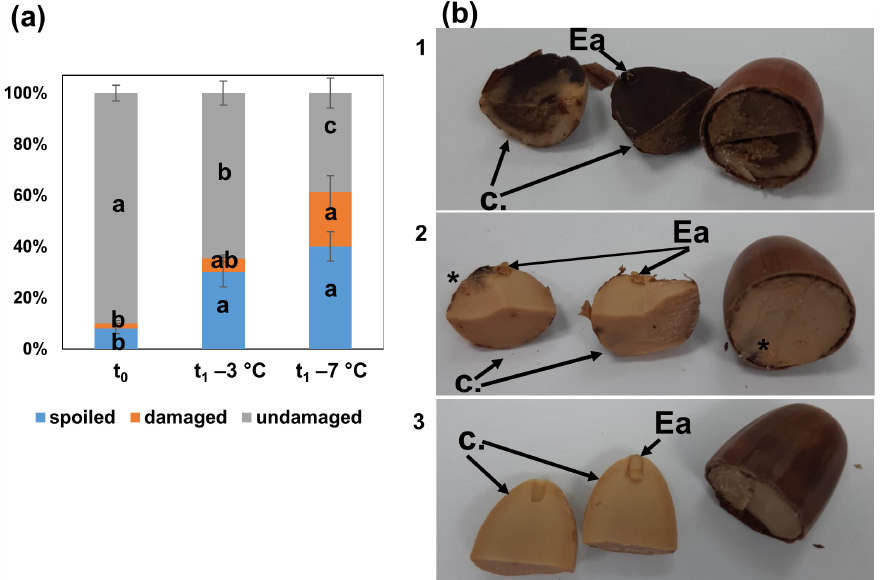
Figure 2. The percentage distribution ( a ) and visualization ( b ) of seed classes utilized for metabolomics comprising spoiled seeds rejected from metabolomics study (image b1), seeds exhib-